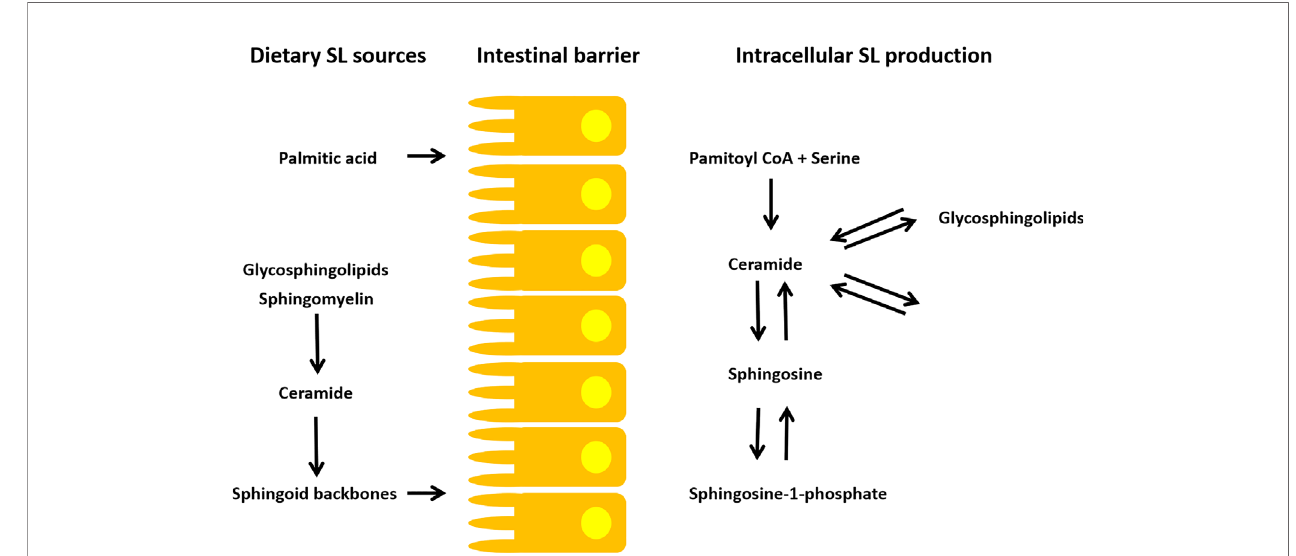
FIGURE 2 | SL metabolism of dietary and intracellular SLs. A luminal breakdown to sphingoid backbones is required for intestinal absorption of exogenous SLs. Additionally, dietary palmitic acid consumption is suggested to modulate endogenous SL production (35, 36). The endogenous SL metabolism is highly complex. Cers are the branch point of SL homeostasis. They are synthesized via SM/cerebroside hydrolysis, de novo synthesis (palmitoyl-CoA + serine) and via the salvage pathway (e.g. Cer to S1P/C1P and vice versa). Subsequently, many SL metabolites can be generated from the Cer building